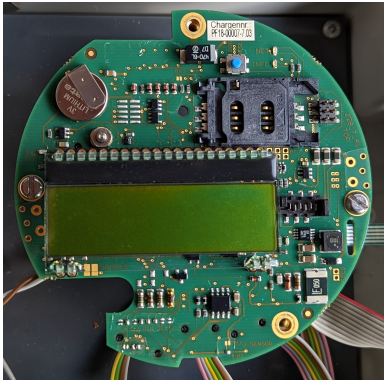
Figure 7. Electronic platform